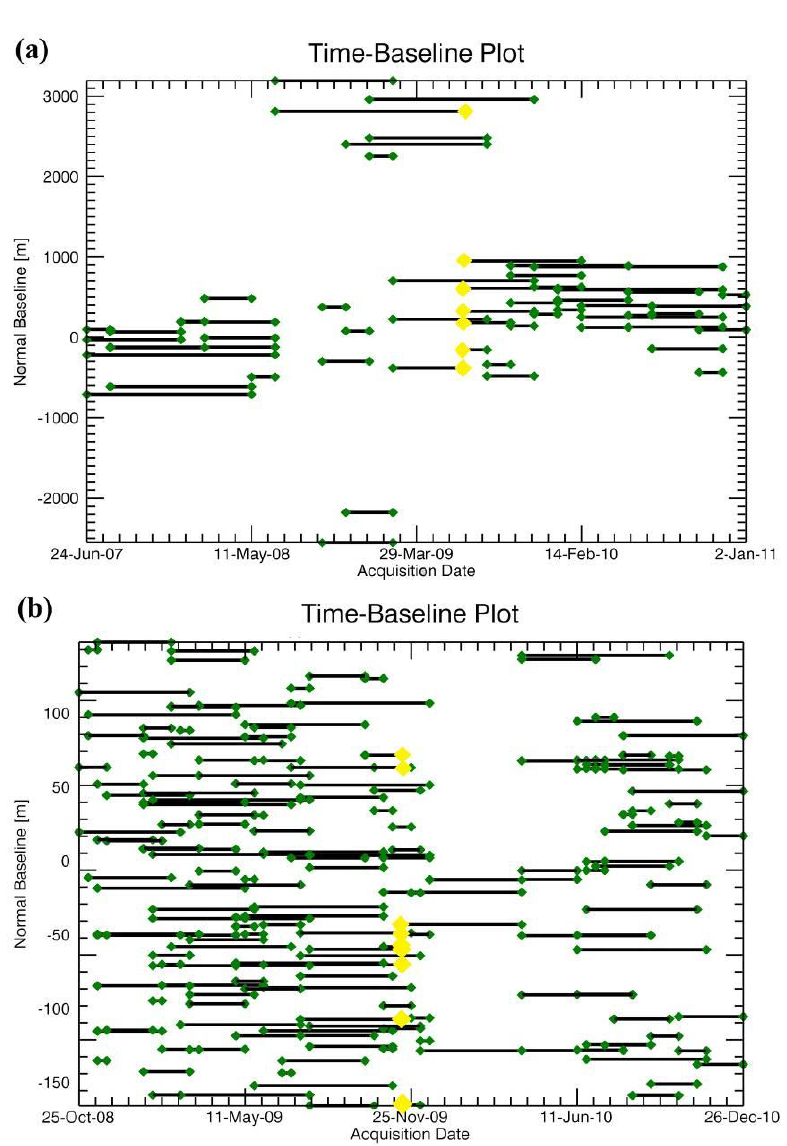
Figure 2. Small baseline formation, ( a ) ALOS PALSAR; ( b ) TerraSAR. Yellow points indicate the reference imagery for temporal image